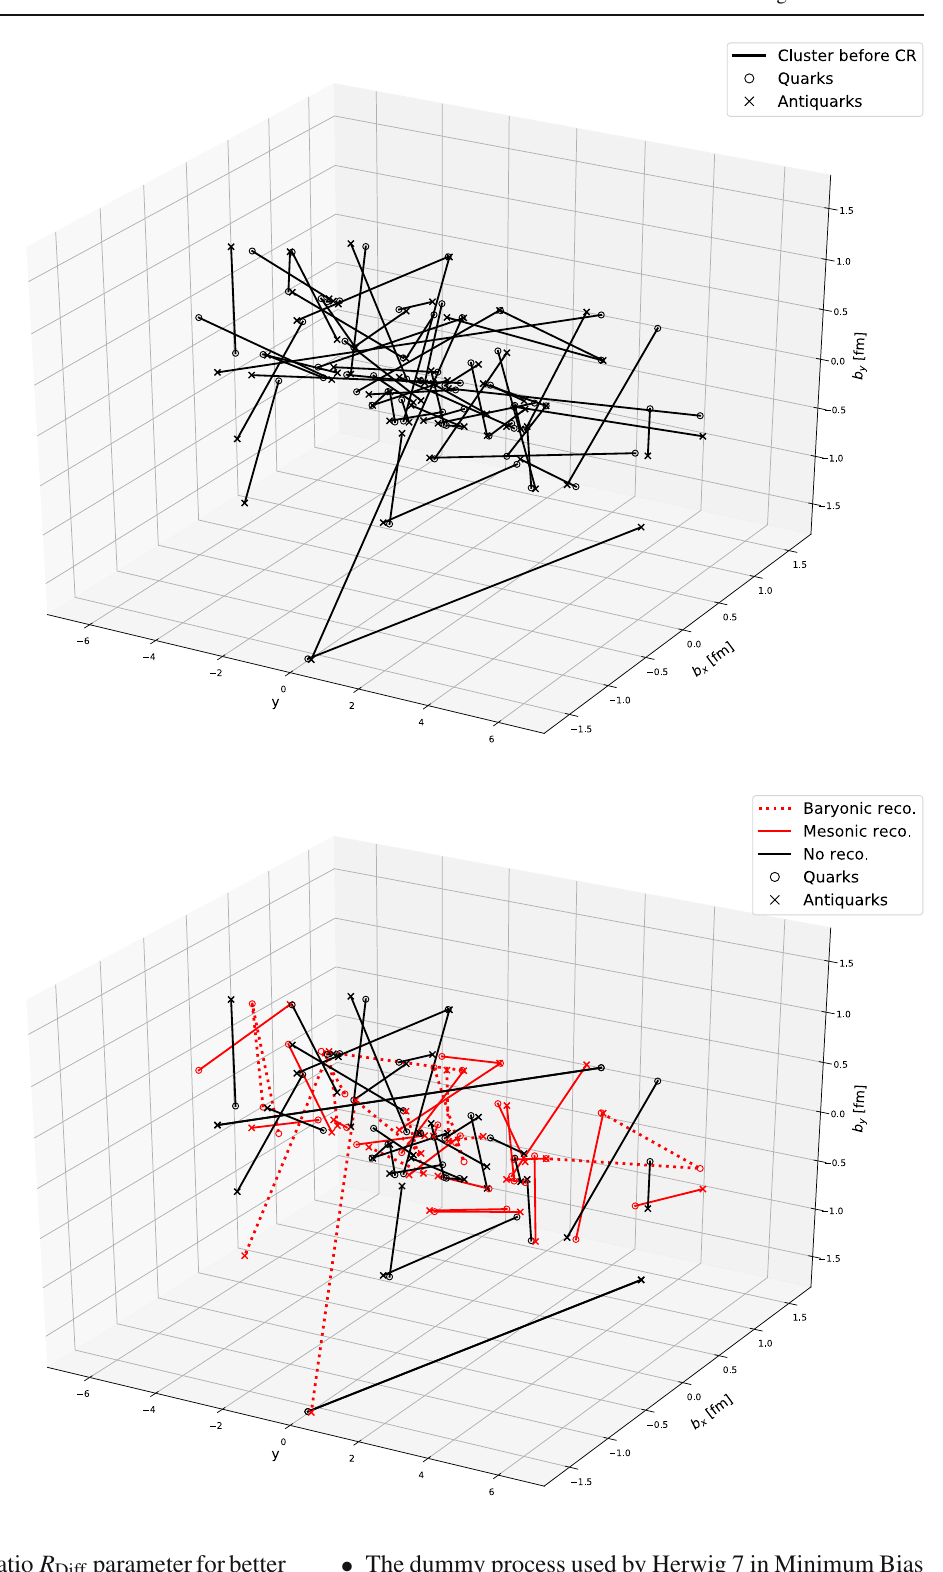
Fig. 7 The colour-topology of a sample Minimum Bias event in rapidity and transverse spacetime coordinates, before (top) and after (bottom) colour reconnection. The parameters used for reconnection here are ν 2 = 1 GeV 2 , d = 0 . 5 fm, and 0 baryonic reconnection weight w = 0 . 5. Black lines b correspond to clusters which are automatically produced from the parton shower and which have not undergone any colour reconnection, while red lines are the newly rearranged (dotted lines) baryonic and (solid lines) mesonic